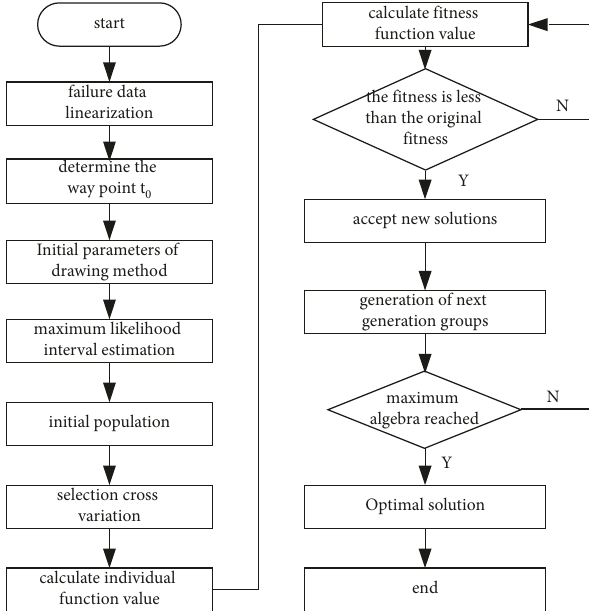
Figure 6: Flowchart of parameter solving algorithm based on minimum distance